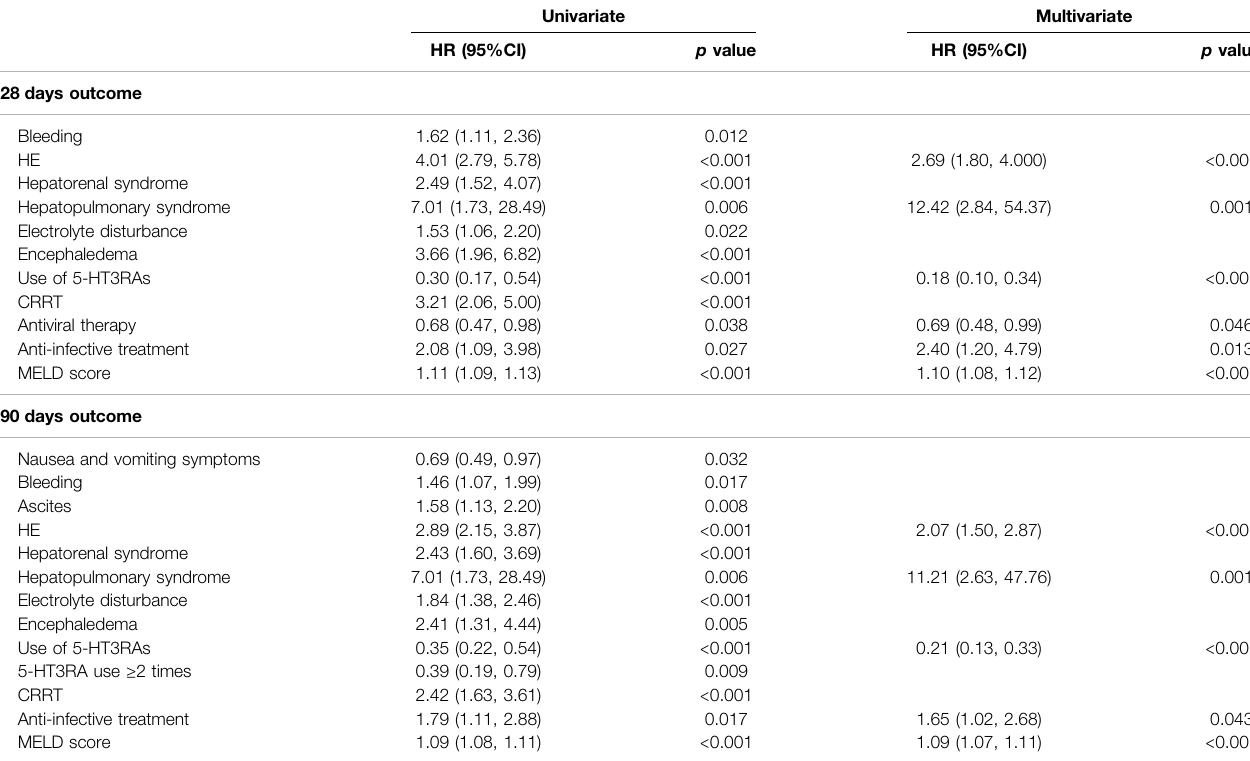
TABLE 2 | Univariate and multivariate Cox regression analyses of variables and 28 and 90 days outcomes before propensity score matching. Univariate Multivariate HR